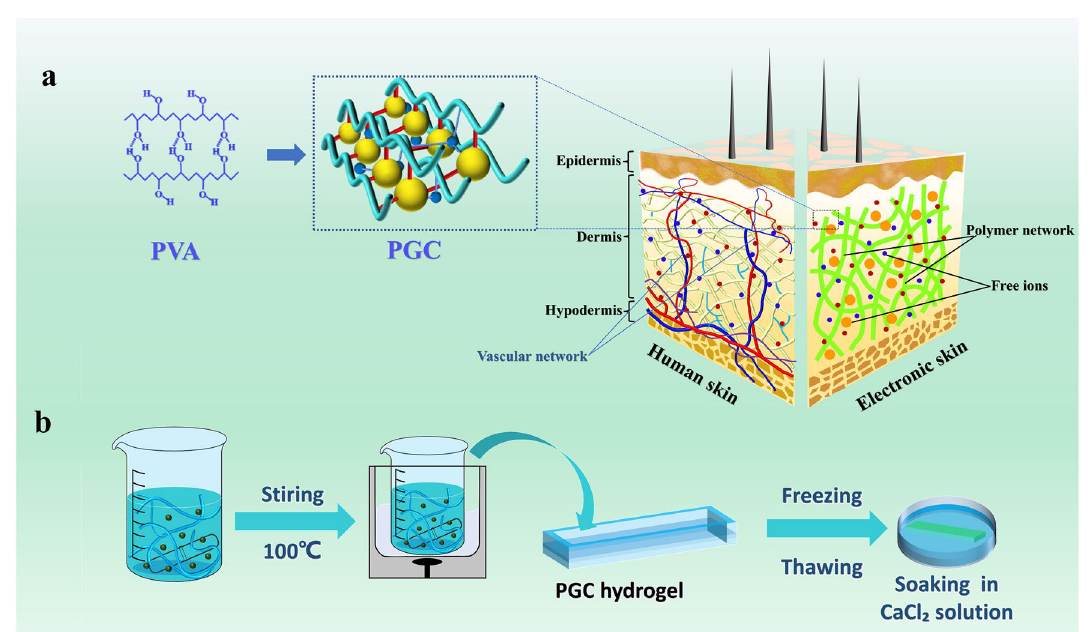
Fig. 1 Structural properties of PGC supramolecular hydrogel. a Microscopic composition and skin-like properties of PGC hydrogel. b Produc- tion process of PGC